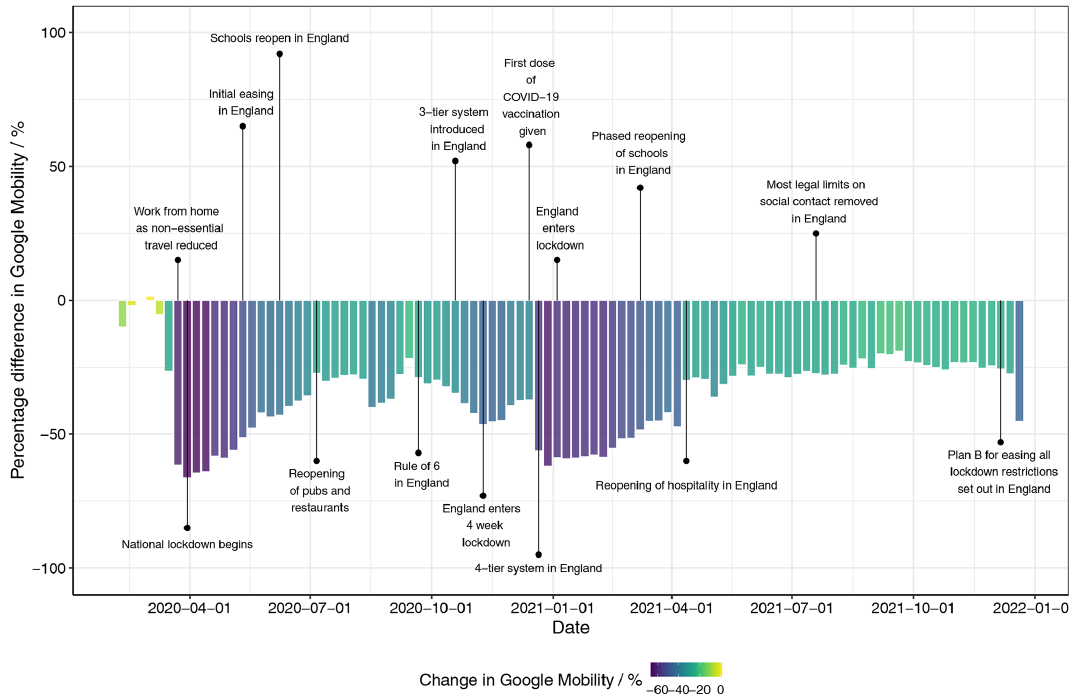
Figure A1. A timeline of COVID restrictions in England from the start of the COVID-19 pandemic until January 2022. Coloured bars represent the weekly change in Google mobility across the